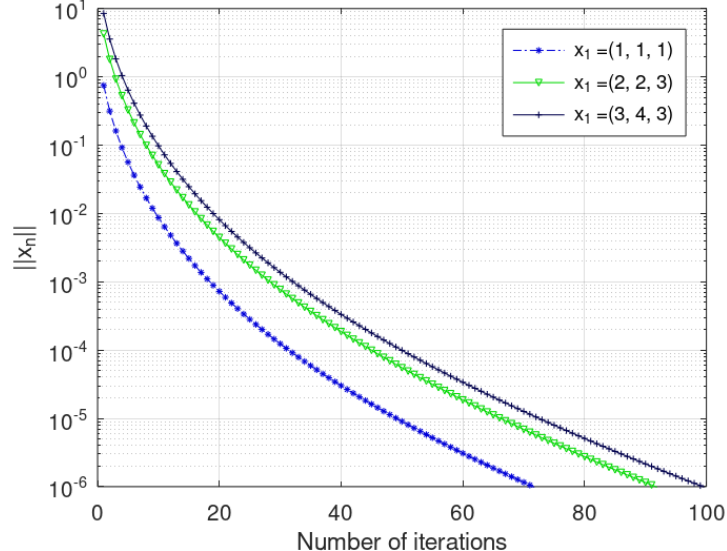
Figure 1. Convergence graph of (cid:107) x n (cid:107)